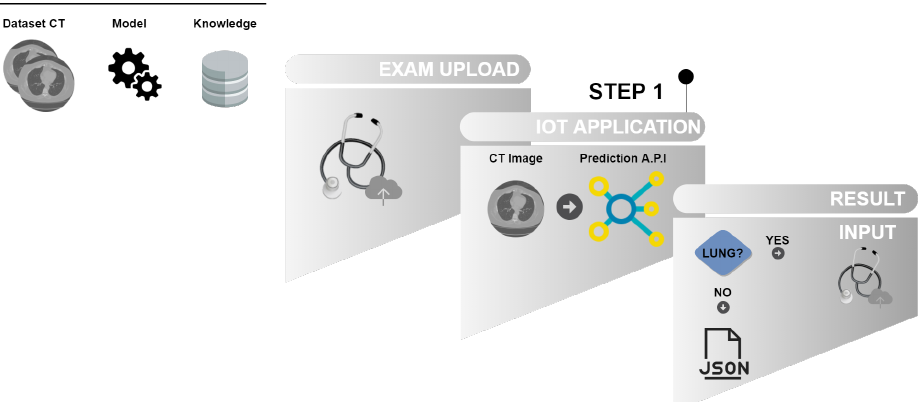
Figure 3. The API uses different CNNs and classifiers in an IoT-based architecture for the classification of lung images according to their presence or not in the other slices of the exam. The API uses a graphical interface for more significant interaction with the user, in which the user inserts the image bank and the classes to be classified. This interface then communicates with the server, which contains the algorithm (endpoint) that will apply the different CNN models used. Then, through Transfer Learning, it sends the attribute vectors to the classifiers used. This event co-occurs; each CNN model receives the same images and sends them to their respective classifiers. This process co-occurs, as there is a need to find the best combination of the CNN model for extraction and its respective classifier.